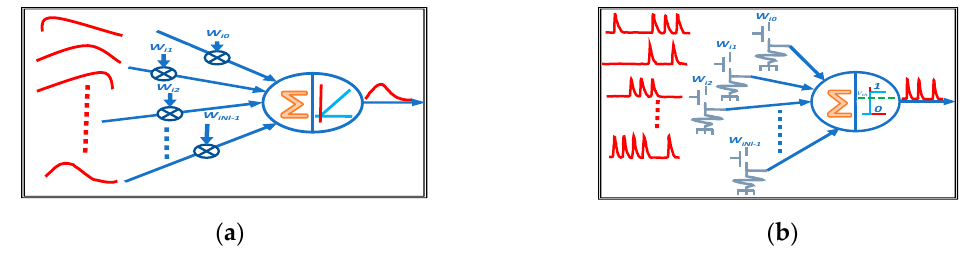
Figure 2. ( a ) ANN neuron model; ( b ) SNN neuron model.